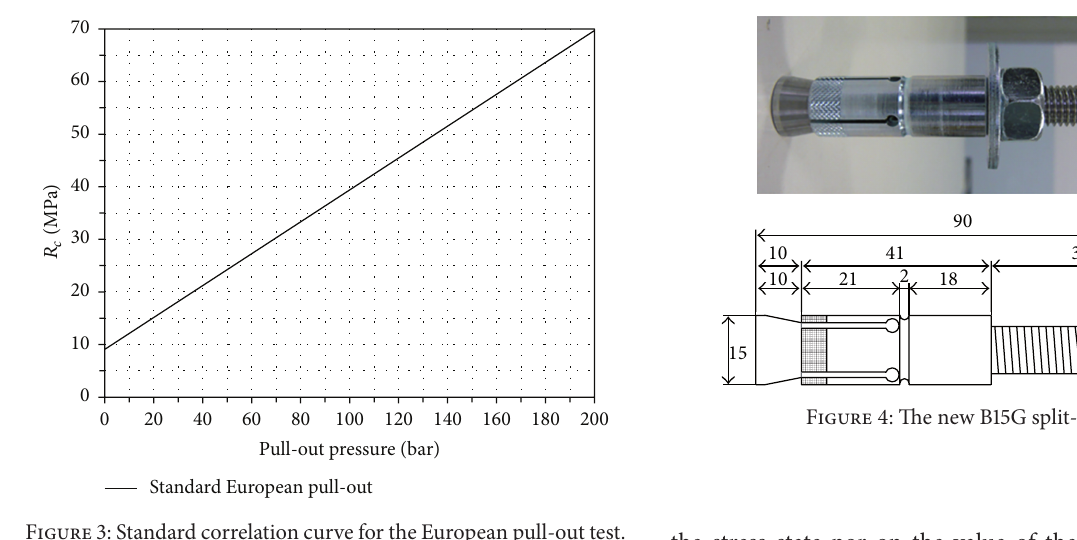
Figure 3: Standard correlation curve for the European pull-out test. 𝑅 𝑐 = cubic compressive strength.